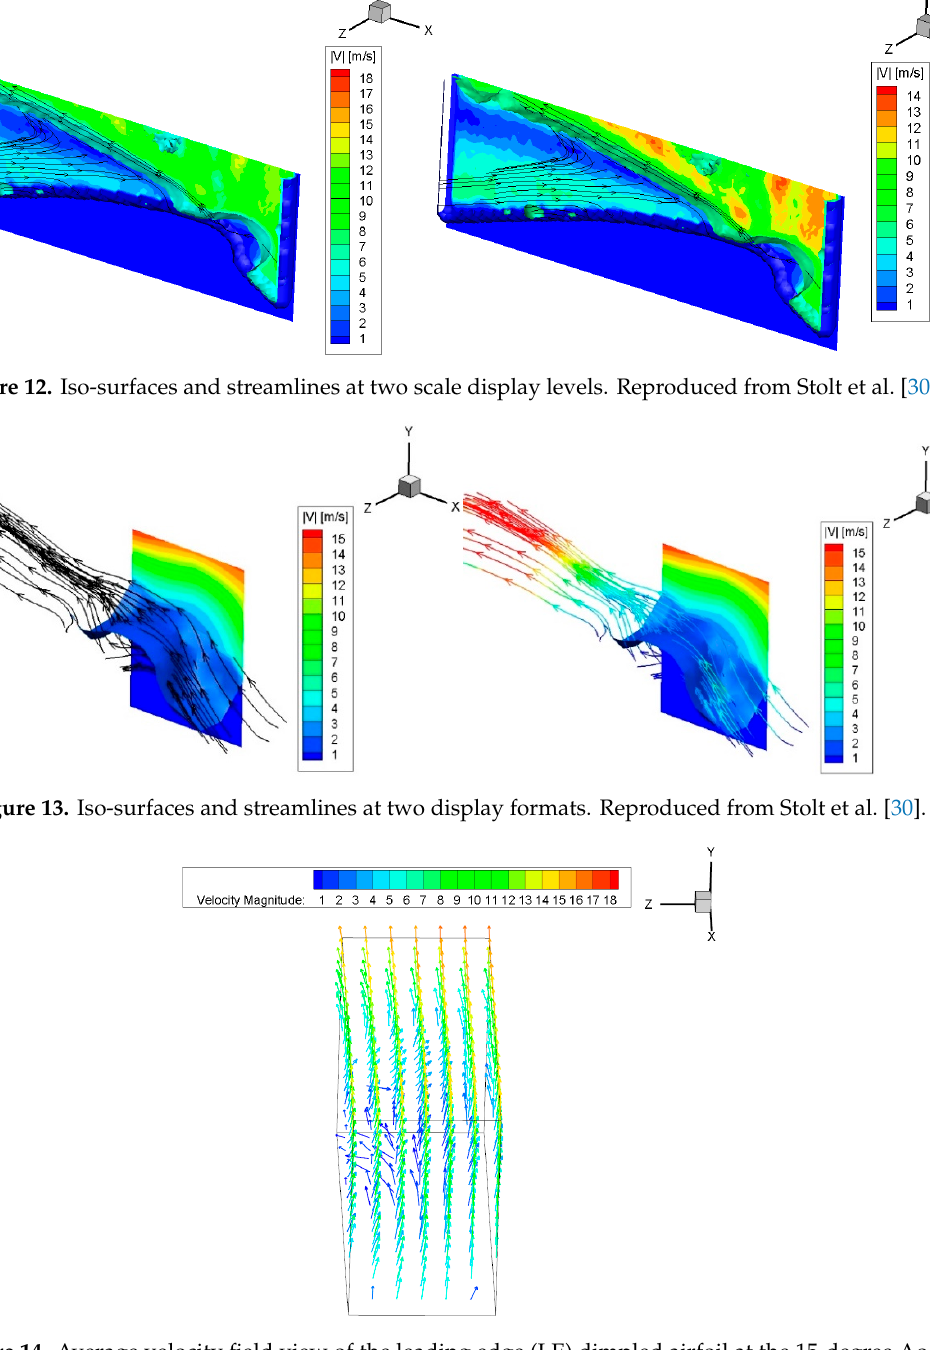
AoA. Reproduced from Stolt et al. [30].